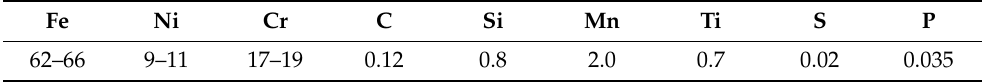
Table 5. Chemical composition of 12KH18N10T stainless steel in